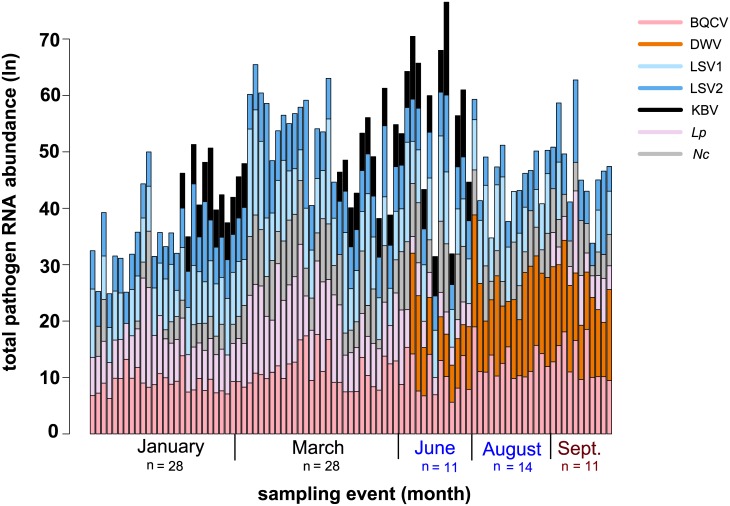
Longitudinal assessment of honey bee pathogen abundance at the colony level.Spatiotemporal change of the pathogen composition of individual honey bee colonies is designated by each vertical bar. In this sample cohort, the most prominent changes are attributed to the detection of DWV and reduced abundance of L. passim (Lp) in June, August, and September. Quantitative PCR was used to determine the relative pathogen abundance (S3 Table). The natural log transformed data for each pathogen, BQCV (pink), DWV (orange), Lp (light pink), Nc (gray), LSV1 (light blue), LSV2 (dark blue), and KBV (black), is represented by the height of each segment of the vertical bar representing a sample from an individual colony (y-axis); the height of the bar represents the total pathogen abundance for each colony over the course of the study (January to September 2014, x-axis).